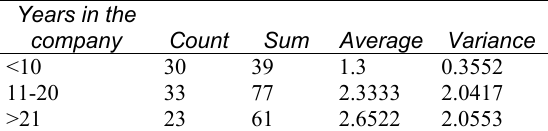
Table 3. Summary of statistics from question